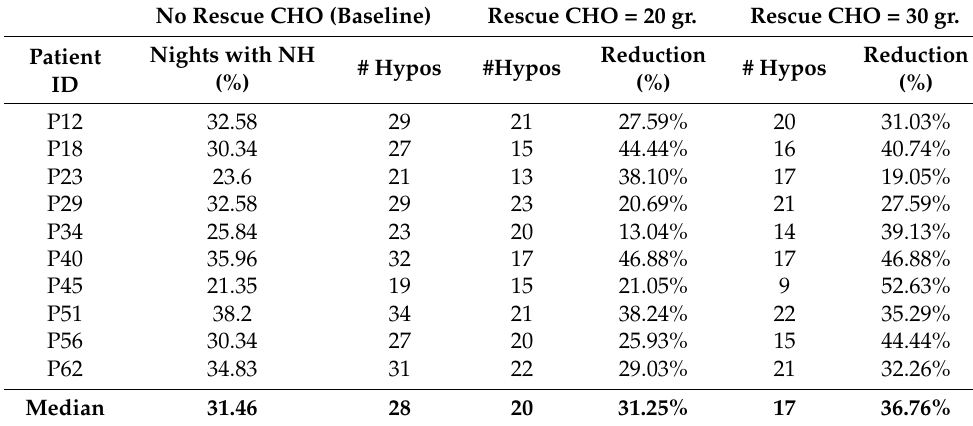
Table 5. Percentage of nights with nocturnal hypoglycemia (NH) between 00:00 and 06:00 for 20 and 30 g of rescue CHO ( p -values < 0.0005).